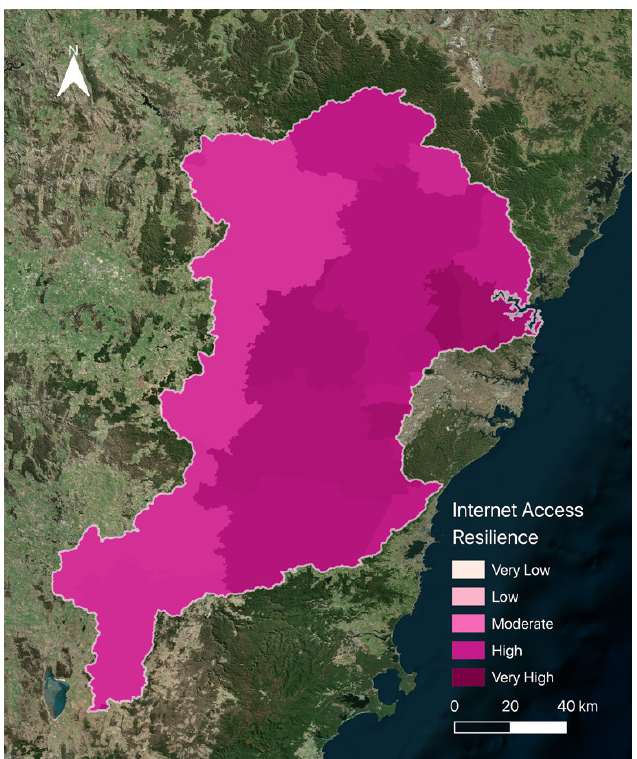
Figure 9. Internet Access Resilience after standardising using fuzzy membership processing. Resil- ience measured from Very Low (light pink) to Very High (dark pink).